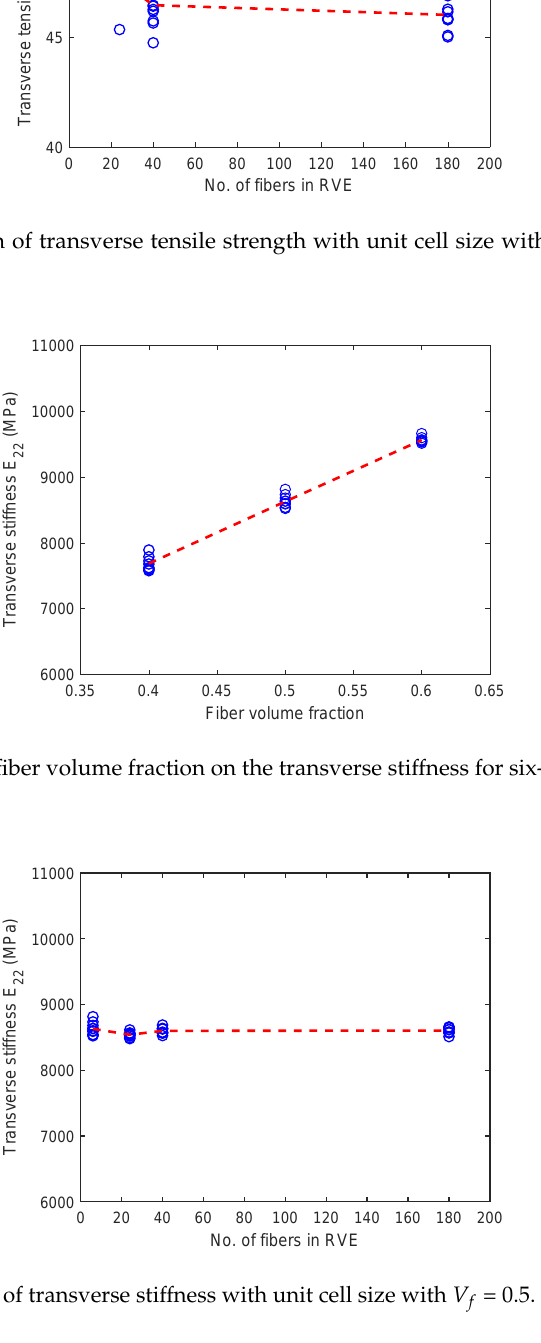
f = 0.5. (D’Mello and Waas